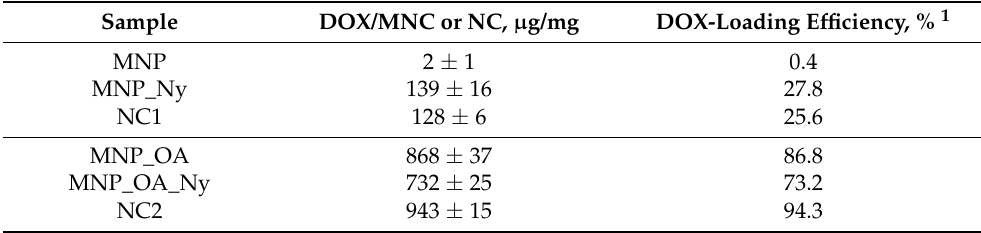
Table 3. DOX-loading capacity and loading